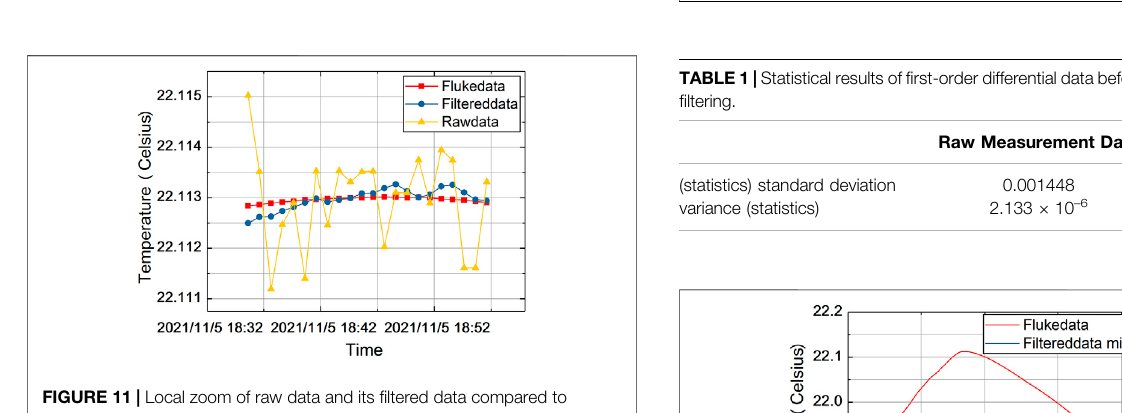
FIGURE 13 | Comparison of the fi rst-order difference results of the data before and after fi ltering.